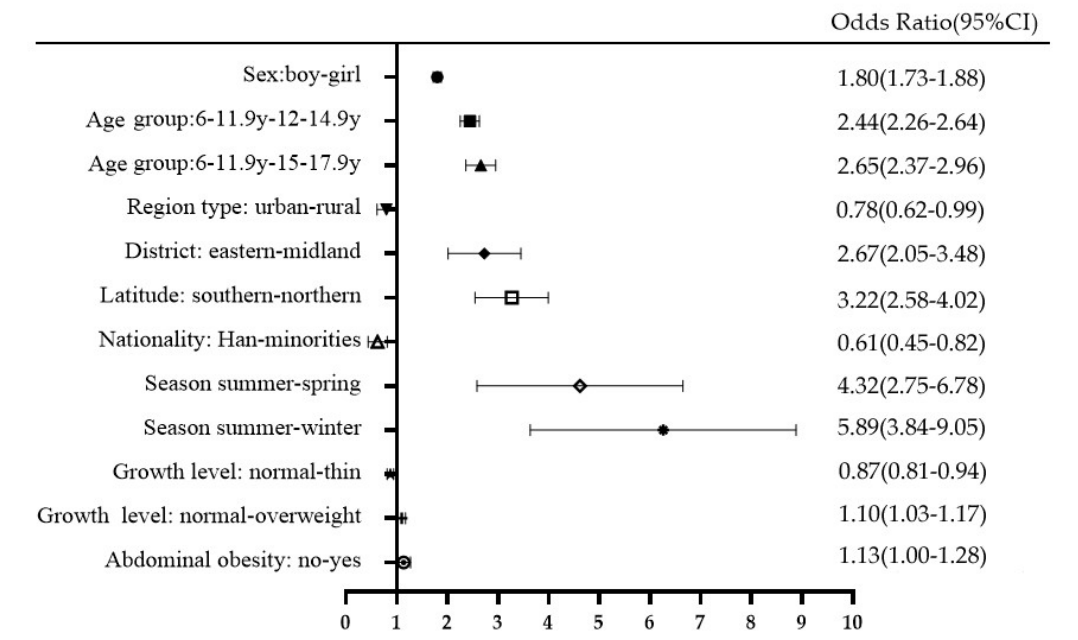
Figure 1. Risk factors for vitamin D inadequacy in CNNHS 2016–2017 (vitamin D insufficiency and